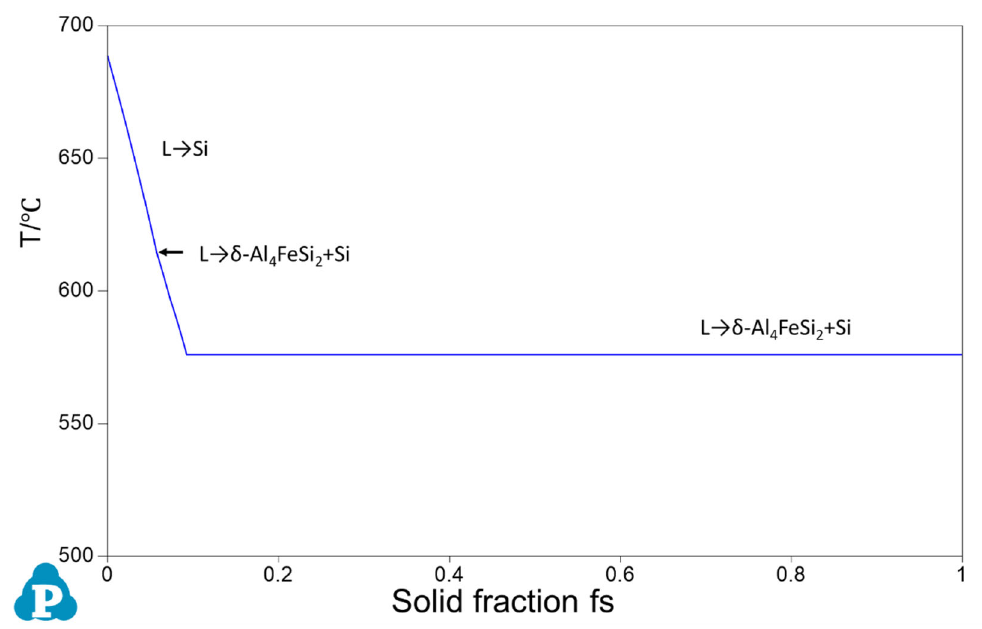
Figure 11. The calculated solidification curve for Al ‐ 20Si ‐ 0.7Fe alloy using the Scheil model showing that solidification starts at 688 °C with the formation of the equilibrium primary Si phase, which is followed by the formation of δ‐ Al 4 FeSi 2 + Si eutectic at 609 °C and β‐ Al 5 FeSi + Si eutectic at 597 °C.